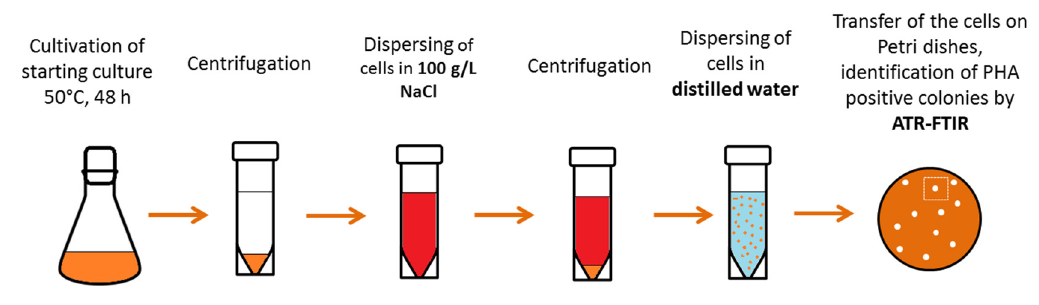
Figure 1. Principle of the “osmoselection”; procedure enabling isolation of PHA-producing